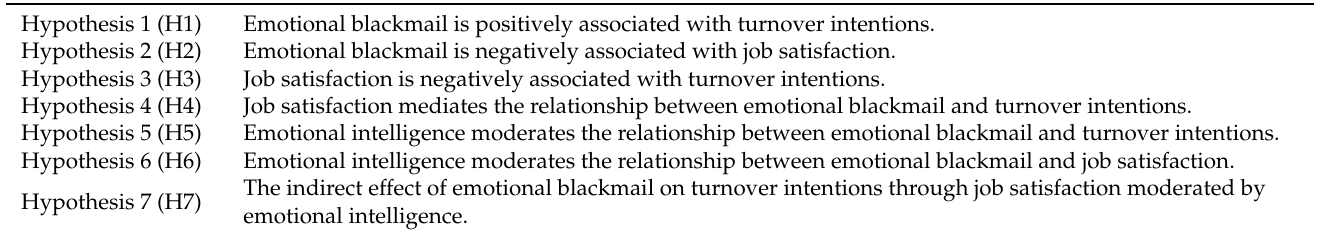
Table 1. Summary of the hypotheses.